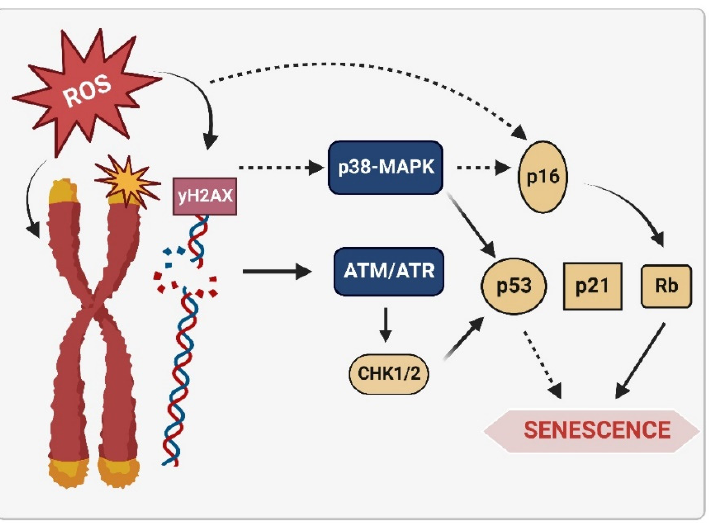
Figure 5. Signaling pathway in response to DNA damage and activation of ROS-mediated senescence. ROS generates telomere damage and DNA oxidation, which activates DDR through p53 signaling for cell cycle arrest. This is recognized by the ATM/ATR sensor proteins, which orchestrate a signaling network by phosphorylating messenger proteins that generate p53 activation. p53 subsequently induces transcription of p21, which activates downstream Rb, and Rb, in turn triggering senescence by stopping transcription of E2F genes and, ultimately, cell cycle arrest or senescence. ROS, in addition to starting DDR by oxidative DNA damage, generates the activation of p53 and p16 for cell cycle arrest through the p38MAPK protein pathway. During aging, there is an increase in damaged cells and the consequent activation of NF κ B in the tissues, which is detected by IS cell recognition receptors, which downstream trigger the activation of NF κ B and which in turn increases Inflammaging [3,12,45] propose